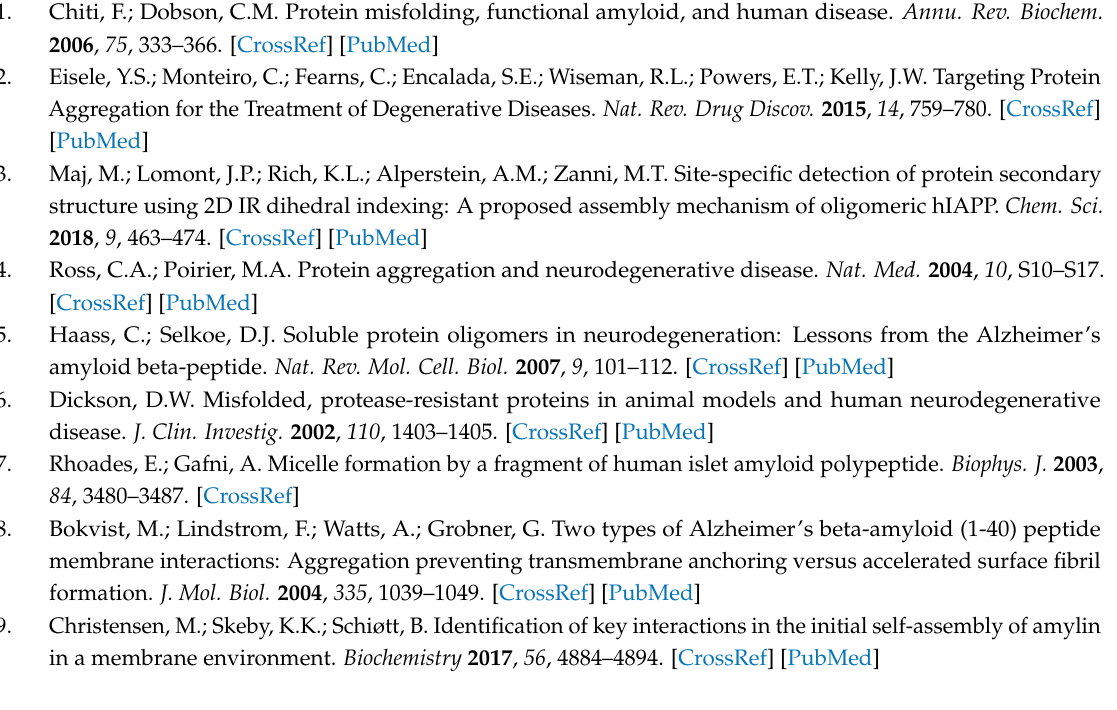
s1, Figure S1: TEM images of L ( D )-NIBC-AuNPs, Figure S2: XPS spectra of L ( D )-NIBC-AuNPs, Figure S3: Time-dependent ThT fluorescence profiles of amylin incubation with different concentrations and AFM image of amylin fibrils, Figure S4: Time-dependent ThT fluorescence profiles of amylin co-incubated in the absence or presence of L ( D )-NIBC with different concentrations, Figure S5: Time-dependent CD spectra profiles of amylin co-incubated with L ( D )-NIBC, Figure S6: Cytotoxicity tests of L ( D )-NIBC with different